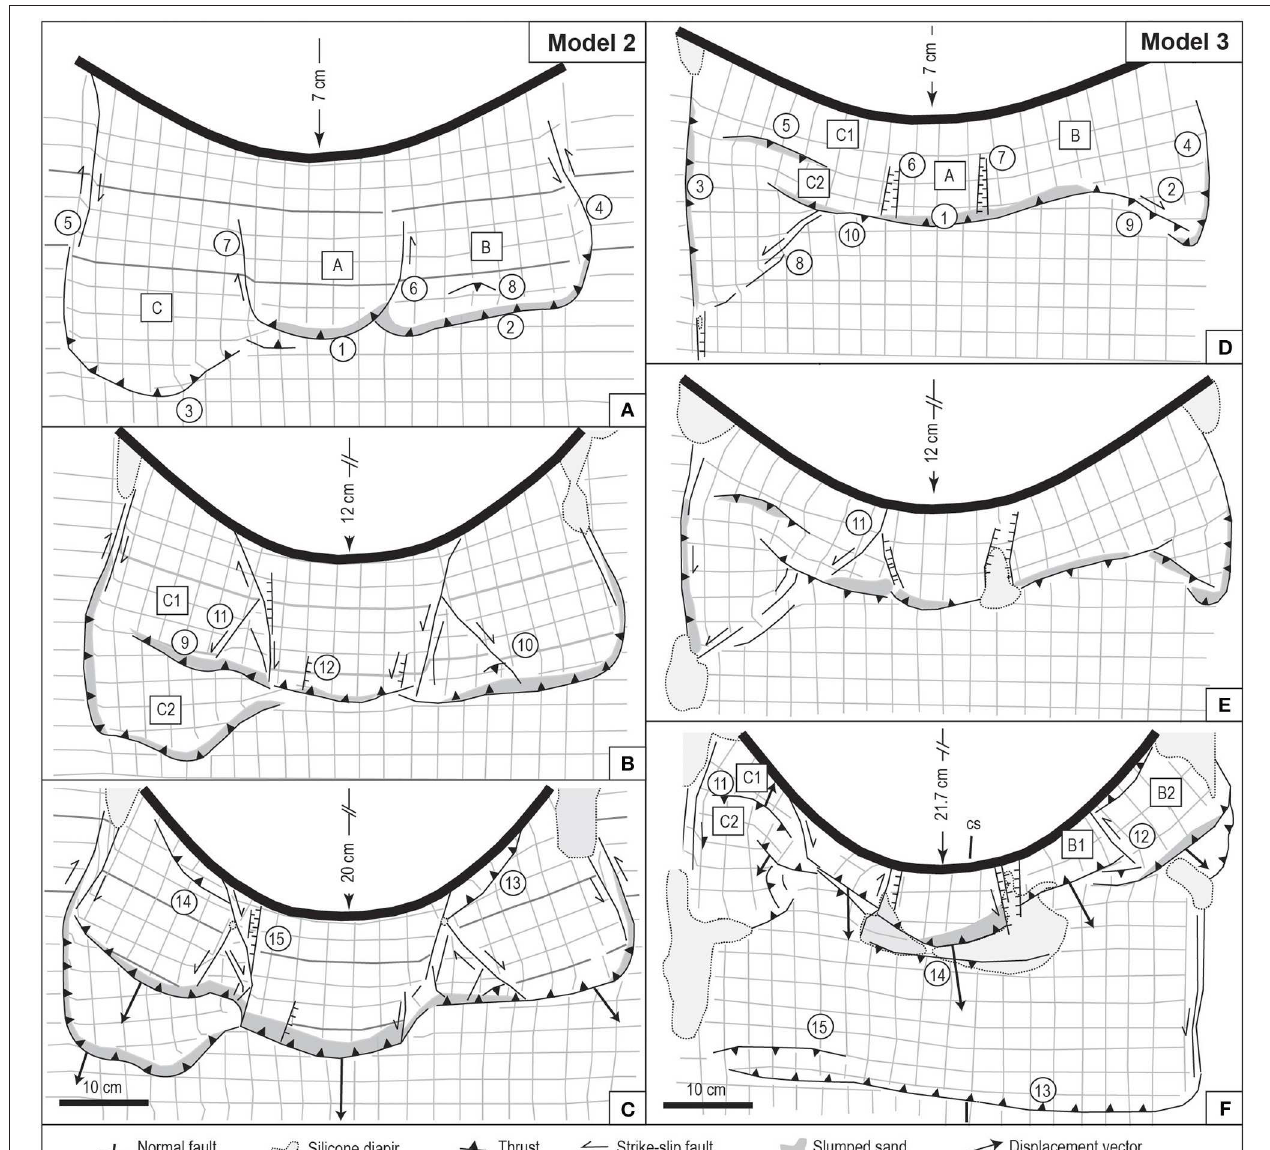
FIGURE 5 | (A–C) Line drawings of different stages of Model 2 (silicone layer of 0.5cm). (D–F) Line drawings of different stages of Model 3 (silicone layer of 1cm). The numbering indicates the relative chronology of the structures. The apex displacement is indicated for each stage. Arrows: displacement vectors along some thrusts [drawn between stages (B,C,E,F) ]. The length of the arrows represents the magnitude of the displacement with the same scale of the line drawings. Cs, cross section of Figure 4C .